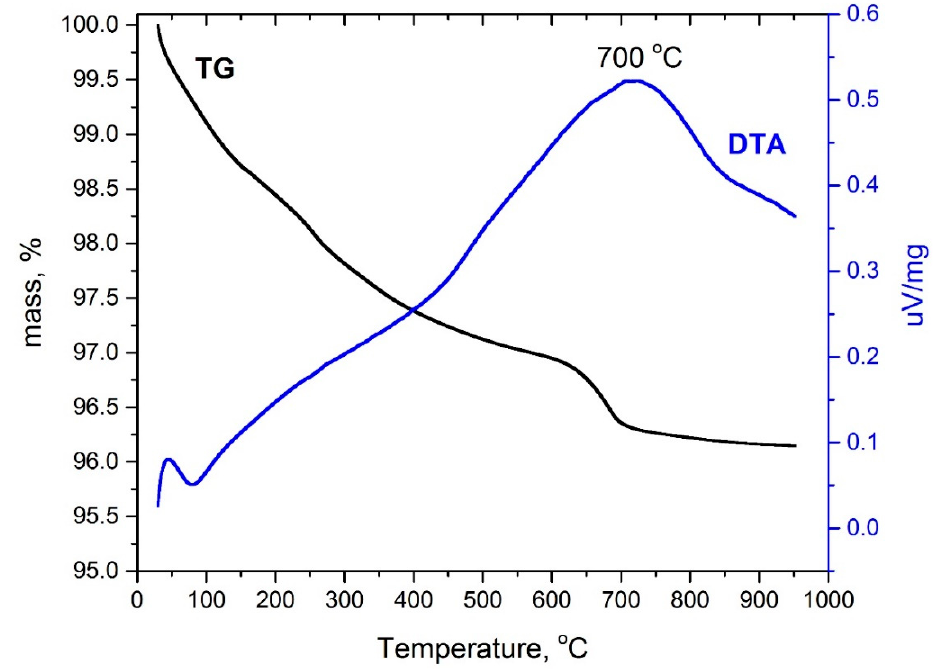
Figure 9. Thermoanalytical data obtained in the heating of La 0.5 Ca 0.5 Mn 0.5 Fe 0.5 O 3 in He flow.